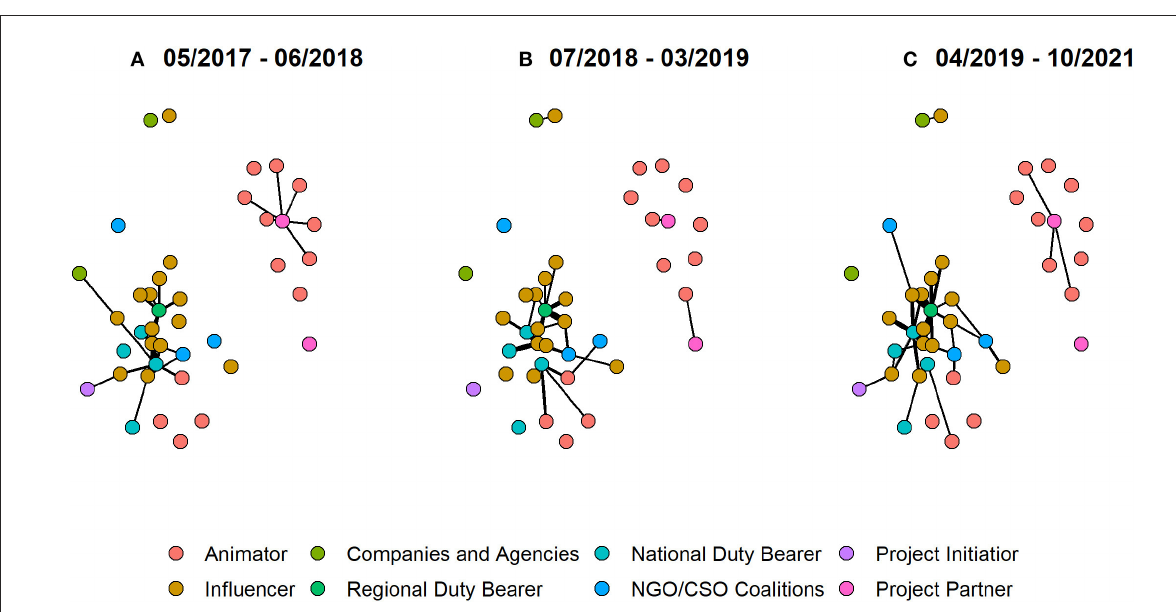
FIGURE7 Reply network between officials and animators/influencers across three different time frames. Part (A) refers to tweets which were posted during the first phase of the project (May 2017 to June 2018), part (B) refers to tweets of the second phase of the project (July 2018 to March 2019), and part (C) refers to tweets posted after the project ended (April 2019 to October